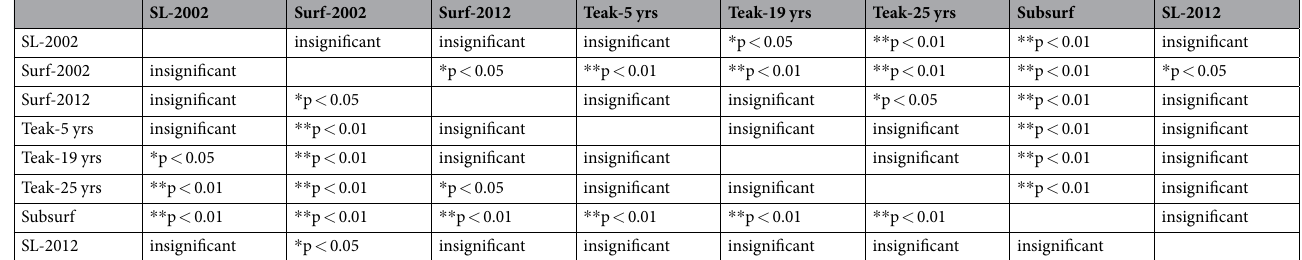
Table 2. Results of the Tukey − Kramer Honestly Significant Difference (HSV) test conducted on 137 Cs activities measured in the soil and sediment sample groups shown in Fig. 5. SL = suspended sediment load, Surf = soil surface ( < 5 cm), Subsurf = soil subsurface (gullies and channel